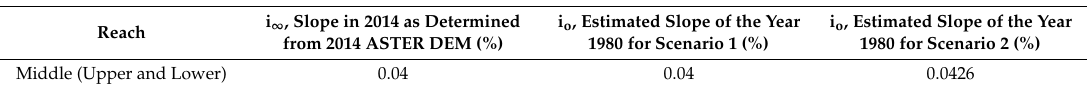
Table 4. Calculated reach-averaged riverbed slope in the year 1980 (before intervention) for the Middle River reach for Scenario 1 and Scenario